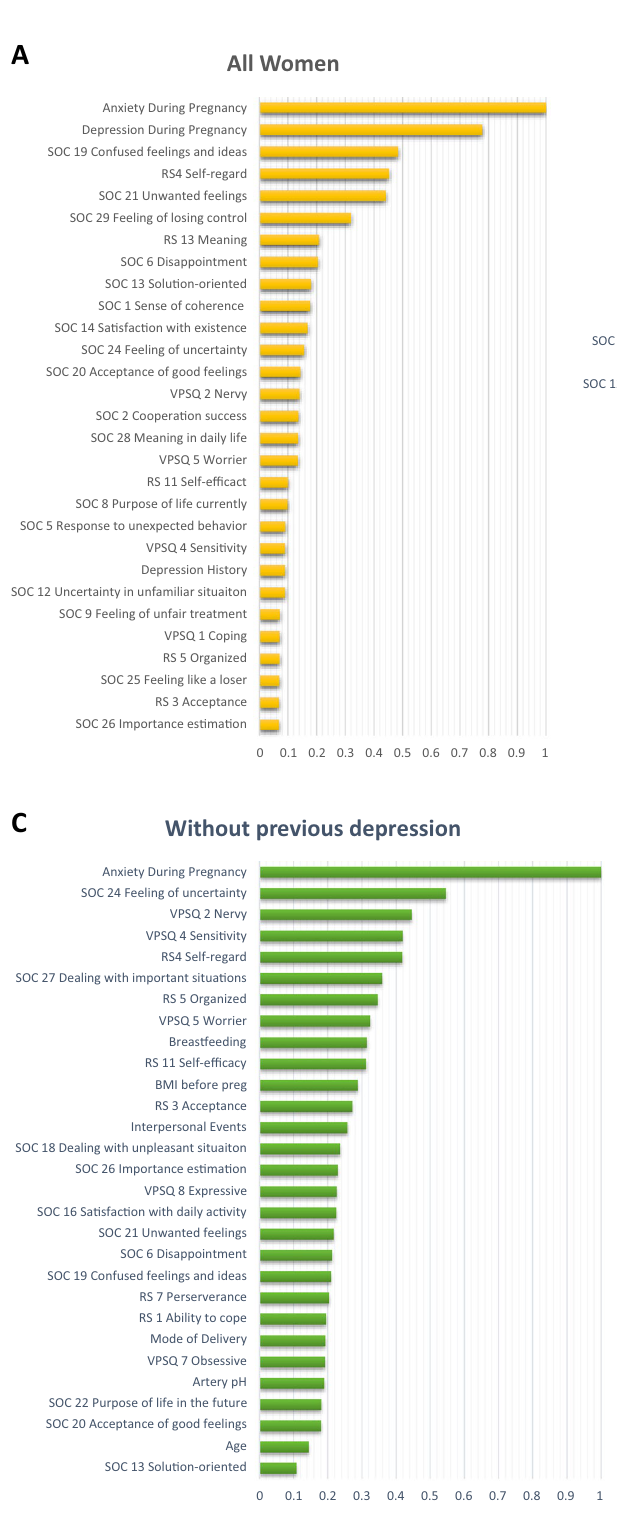
Figure 5. Ranked importance of the assessed variables using the Extremely Randomized Trees (XRT) models in the combined dataset, considering the women with different previous depression status. Results presented for all women ( A ), All women (n = 2385), ( B ) women with depression during current pregnancy or earlier in life (Previous/pregnancy depression, n = 971), and ( C ) women without any previous depression episode (No previous depression, n = 1414). The graphs depict the variable importance as a relative measure that is scaled to a maximum of 1.0. The x-axis represents the relative contribution to the classification algorithm of the corresponding feature on the